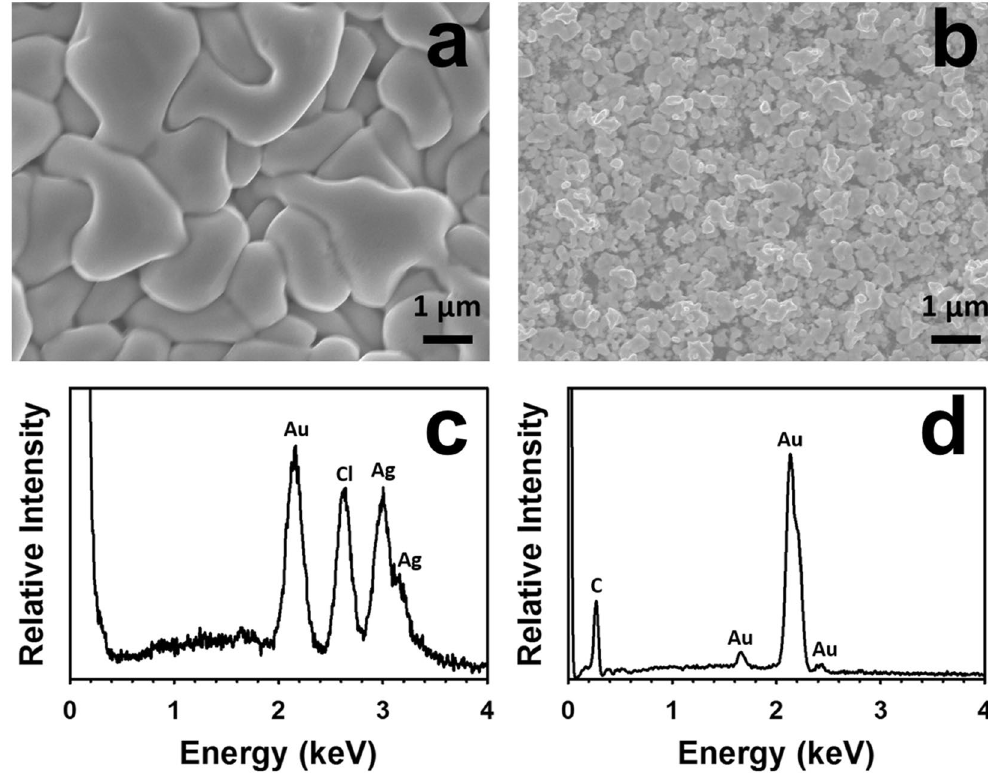
Figure 3. SEM images and EDX patterns of the IDEs of an SWCNT-based sensor at different stages after the Ag-to-Au conversion. ( a ) SEM image of the IDEs after the Ag-to-Au conversion but before the removal of the side product AgCl; ( b ) SEM image of the IDEs after the Ag-to-Au conversion and the removal of the side product AgCl; ( c ) and ( d ) EDX patterns of the specimens shown in ( a ) and ( b ), respectively.